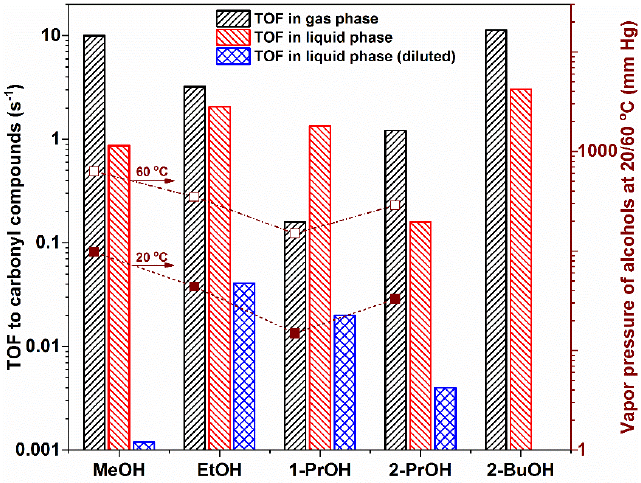
Figure 1. Turnover rates of alcohol oxidation to carbonyl compounds in gas and liquid phases over 6 nm Pt/MCF-17 (4.5 nm Pt/MCF-17 for 1-PrOH oxidation). Gas phase reaction: 1.33 kPa alcohol, 6.67 kPa O 2 , 94.66 kPa He, 60 °C reaction temperature for MeOH, EtOH, 1-PrOH, 2-PrOH and 80 °C reaction temperature for 2-BuOH. Liquid phase reaction: 15 mL alcohol, dissolved oxygen under 100 reaction temperature). Liquid phase reaction (1000 times diluted): 15 mL heptane, 15 μL alcohol with